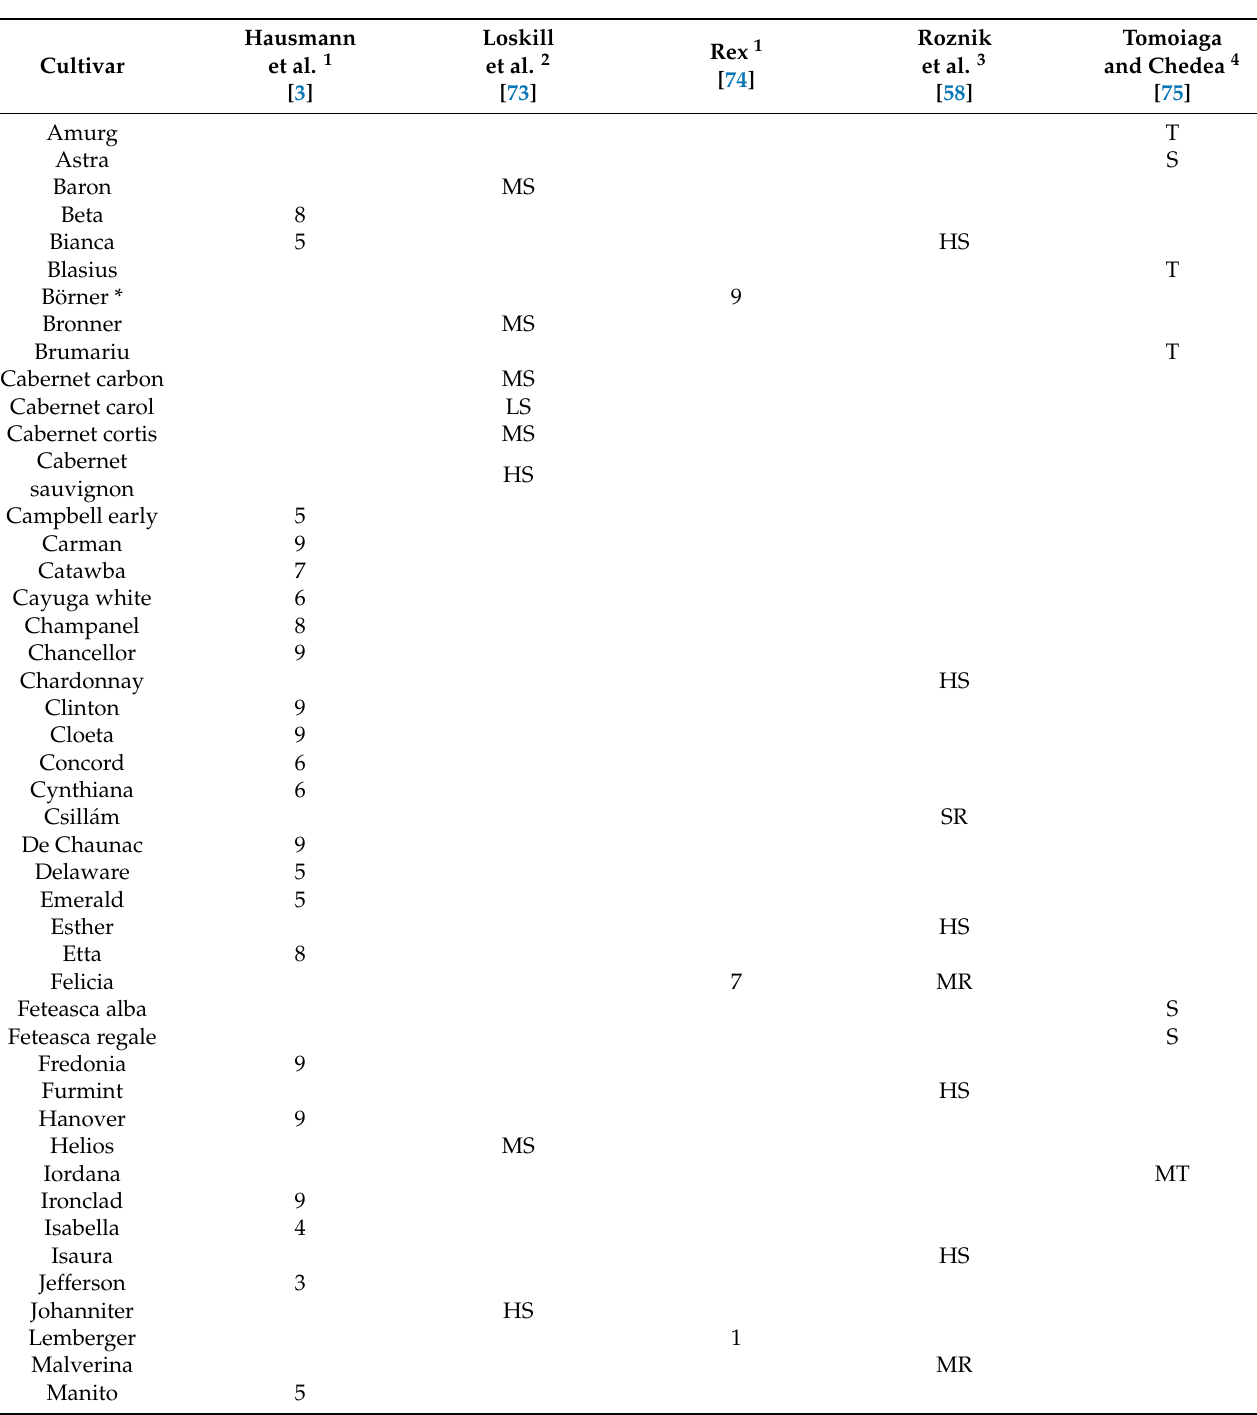
Table 1. Resistance and susceptibility levels of different grapevine cultivars to black